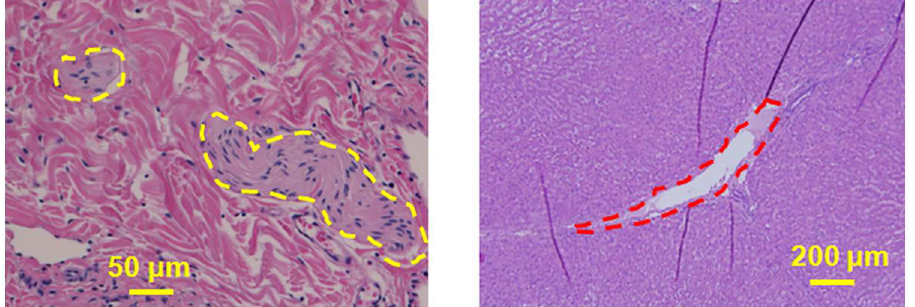
Fig 11. Liver tissue was sonicated with 650 W at 1 Hz PRF. a . Dotted yellow marginsrepresent the nerves in liver tissue that were intact post sonication. These nerves were situated less than 300 μ m from the focal region, showingthe ability of BH to spare nerves. b . Bile ducts located less than 500 μ m from the focal region were also structurally intact (red dotted margin) post sonication. Tissue surroundingthe bile duct was also intact and did not have any signs of